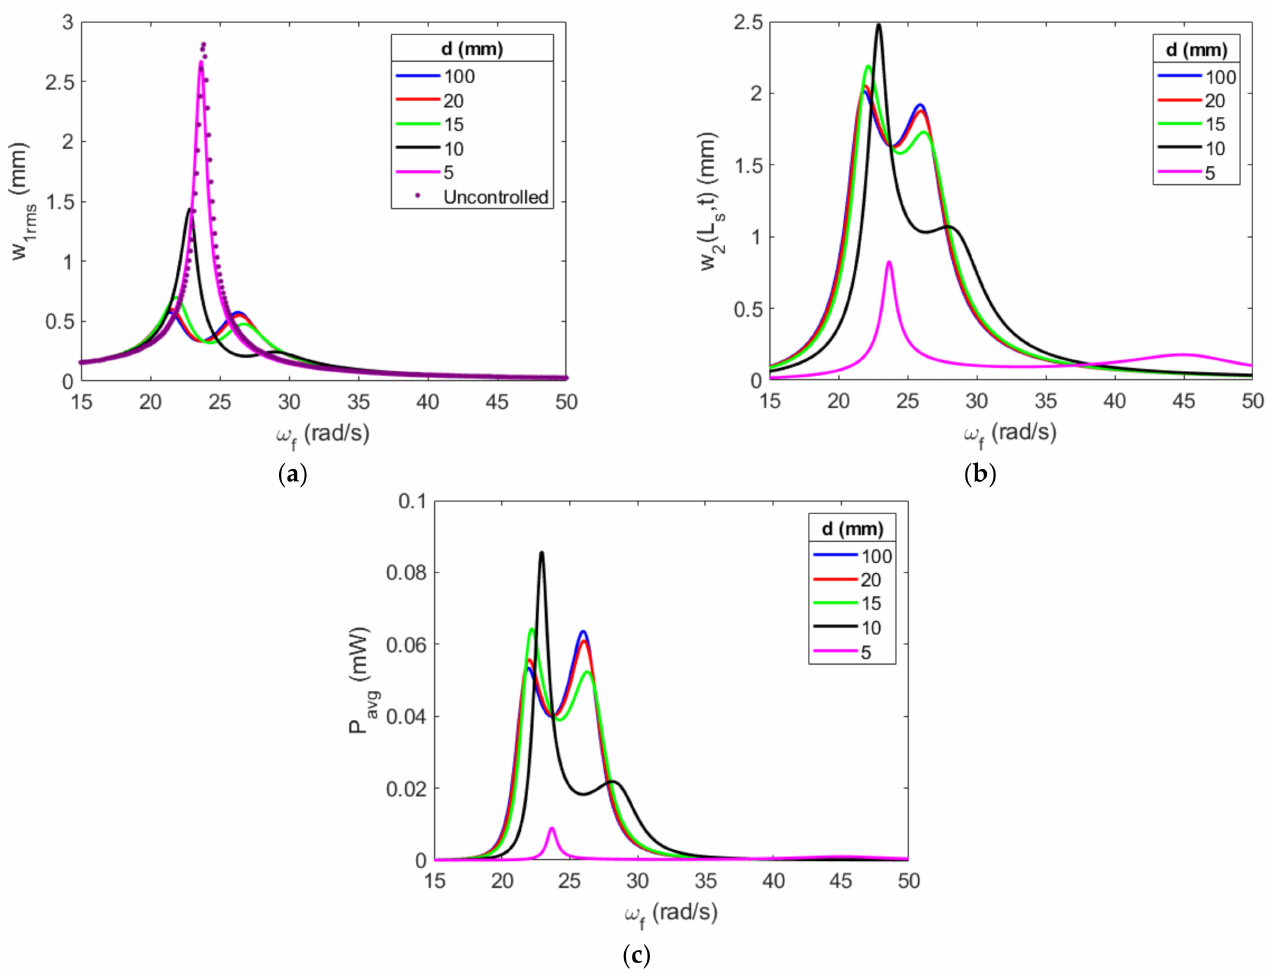
Figure 15. Response of the double repulsive configuration for the ( a ) primary structure, ( b ) absorber’s displacement ( c ) and average power